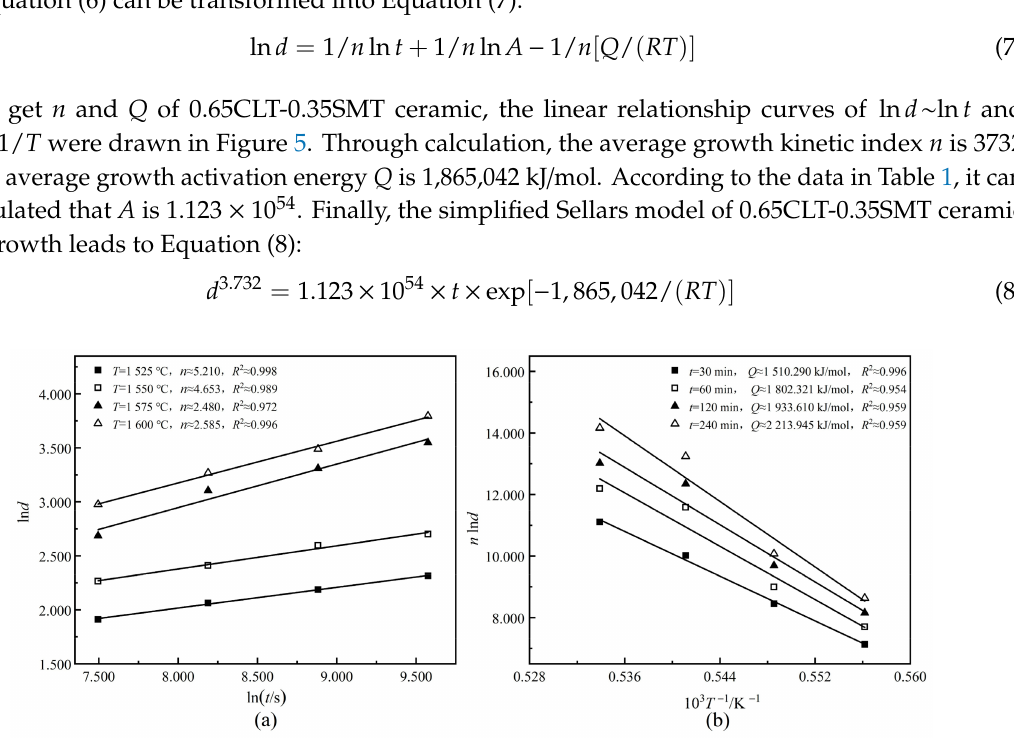
Figure 5. Linear relationship curves of ln d ∼ ln t ( a ) and n ln d ∼ 1/ T ( b ) for the 0.65CLT-0.35SMT